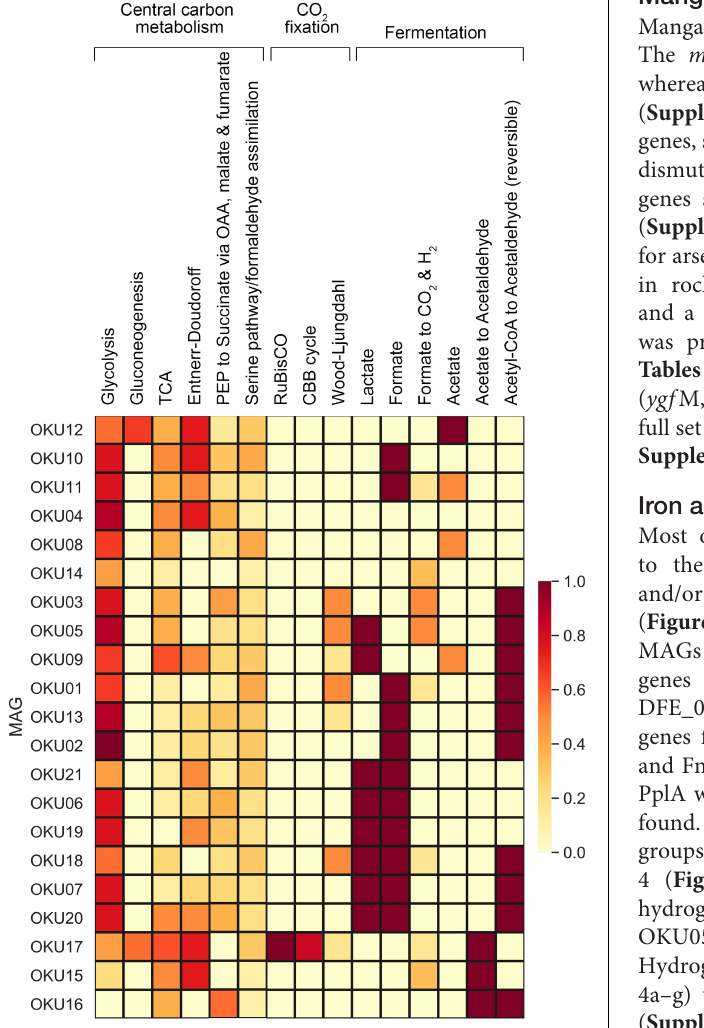
and dmo B) were detected in all MAGs, except